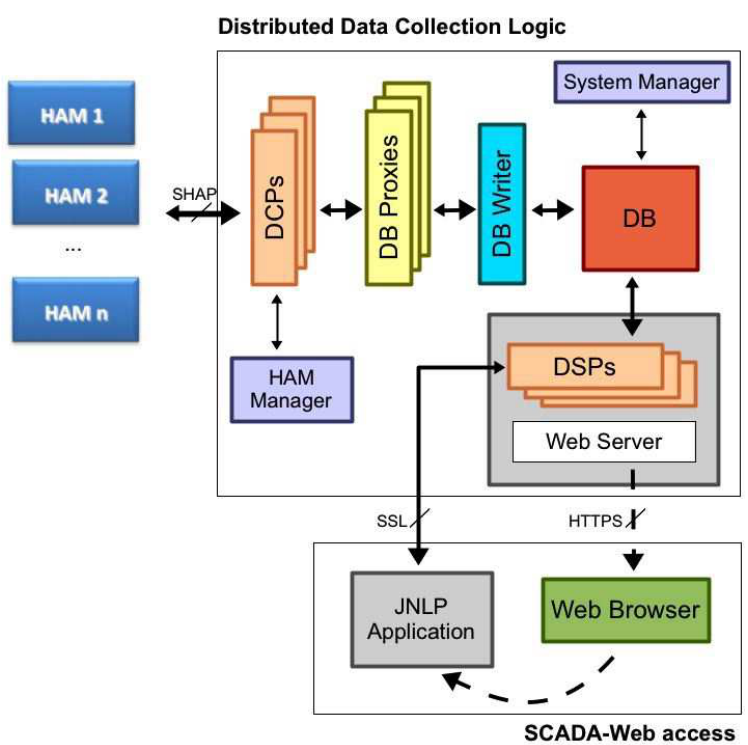
Figure 3. Architecture of the SCADA distributed